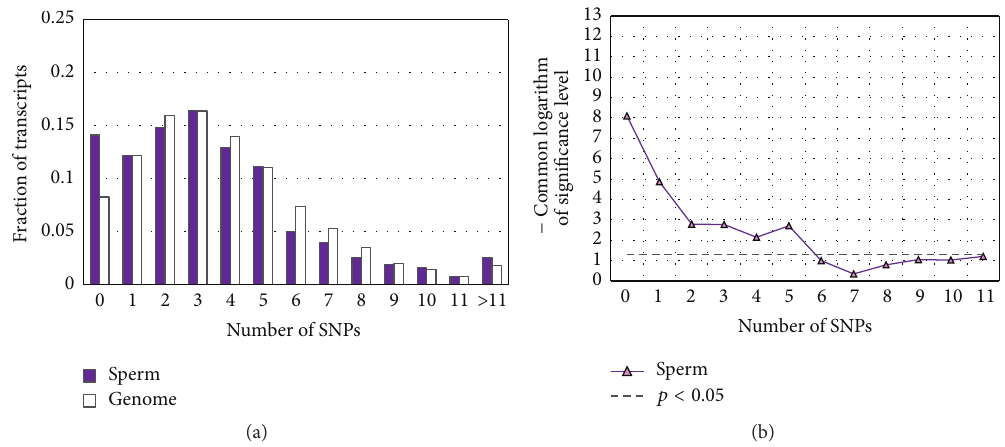
Figure5:ComparisonofSNPcontentdistributionsintheupstreamregionsofhumangenescontrollingspermatogenesis(dataset Sperm )with the distribution in the whole-genome dataset (Table 1). The 5 󸀠 -regulatory regions between − 700 and +100bp around TSSs were analyzed. The genes for dataset Sperm were extracted from EntrezGene by GO term spermatogenesis . In panel (a), the 𝑥 -axis denotes the SNP content, and the 𝑦 axis denotes the fraction of transcripts with specific contents of SNPs in their 5 󸀠 -regulatory regions. Panel (b) presents the significance of the 𝑡 -test ( 𝑦 -axis), which compares the SNP contents in test group with the content in the whole-genome dataset as a function of the threshold of SNP content ( 𝑥 -axis). The 𝑡 -test was applied as described in Section